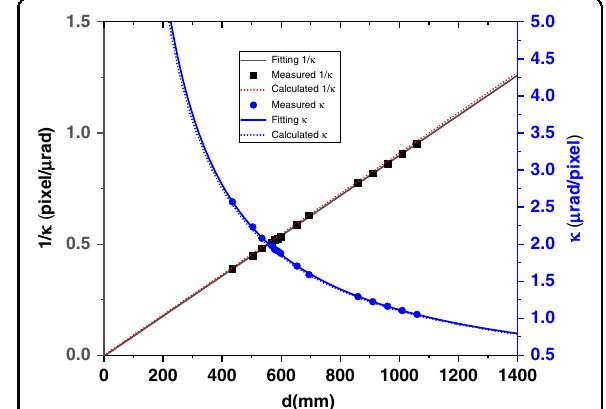
Fig. 9 The speckle displacement for SAM and the measured angle change for AC as function of the NANGO angle over 1000nrad. The slope of the best- fi t line to the SAM data is 3.82E-4 pixel/nrad